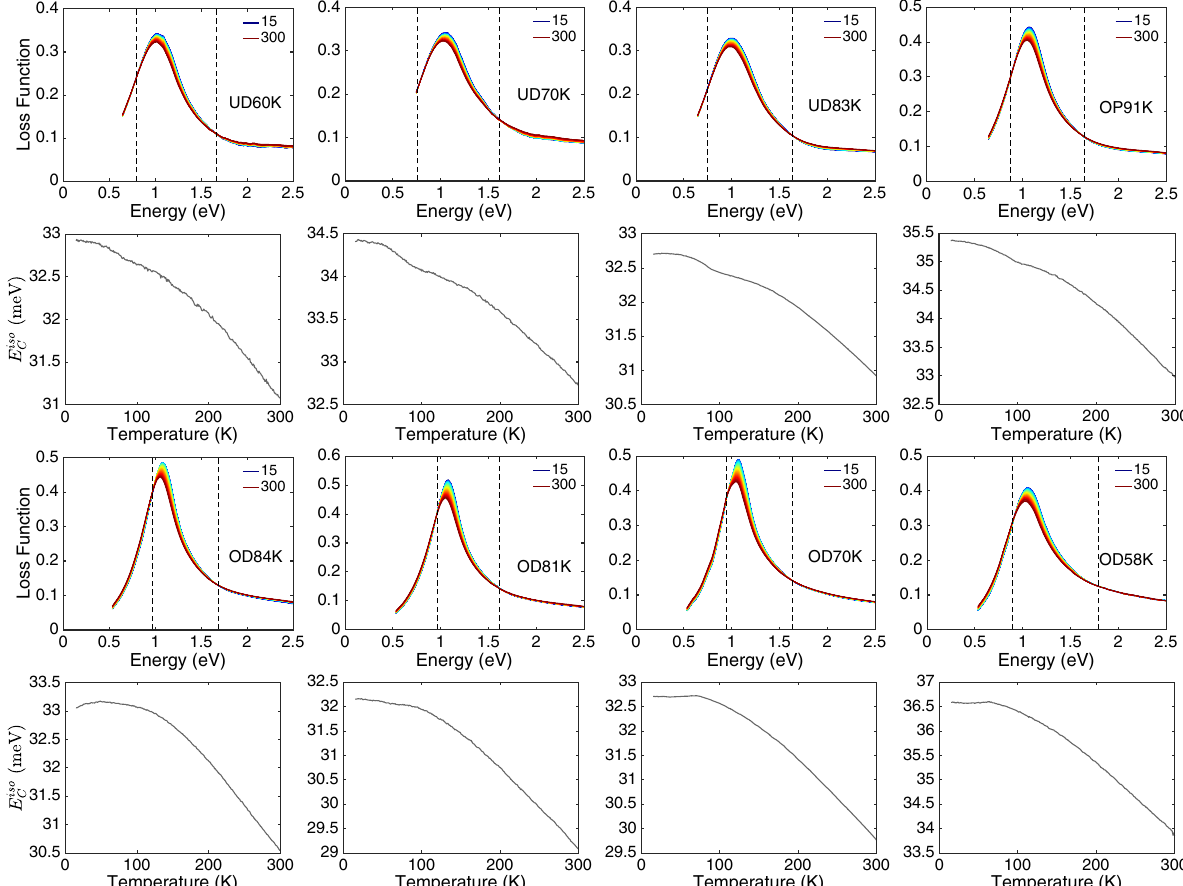
FIG. 2. Loss-function spectra for Bi2212 with carrier concentrations ranging from underdoped to overdoped for selected temperatures (lines 1 and 3). Temperature dependence of the integrated intensity, E iso